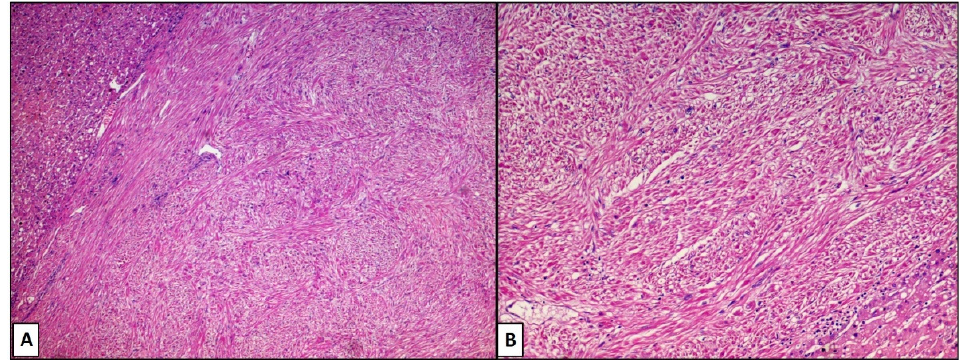
Figure 2. ( A , B ). Photomicrograph comprising a proliferation with mesenchymal habitus, consisting of bundles of fibers intersecting with each other, often at right angles, without evident atypia and/or mitotic figures. Note the well-defined and sharp edges of the lesion (hematoxylin–eosin, original magnification: 4× ( A ) and 20× ( B ).